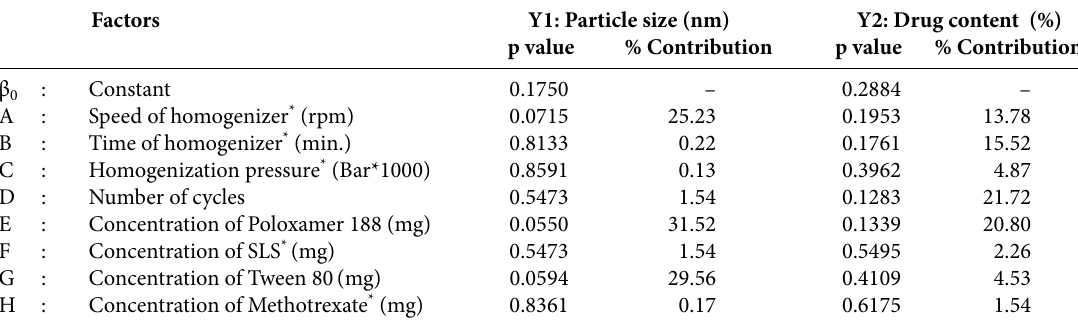
Table 4 . ANOVA analysis for response variables in Plackett – Burman design matrix Factors